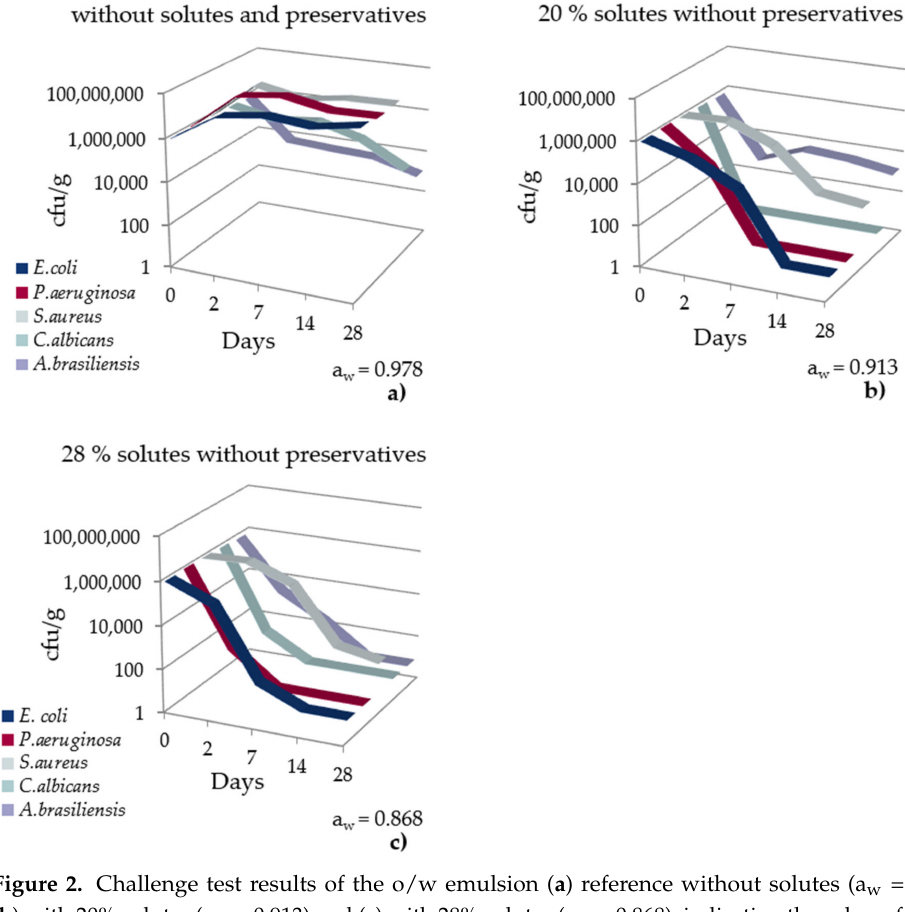
Figure 2. Challenge test results of the o/w emulsion ( a ) reference without solutes (a w = 0.978), ( b ) with 20% solutes (a w = 0.913) and ( c ) with 28% solutes (a w = 0.868), indicating the colony-forming units (cfu/g) for the germs E. coli , P. aeruginosa , S. aureus , C. albicans and A. brasiliensis after 2, 7, 14 and 28 days.